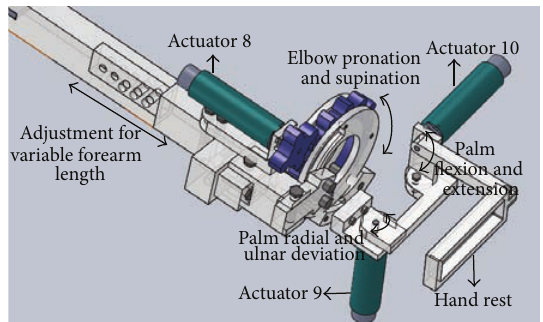
Figure 9: Wrist joint model.